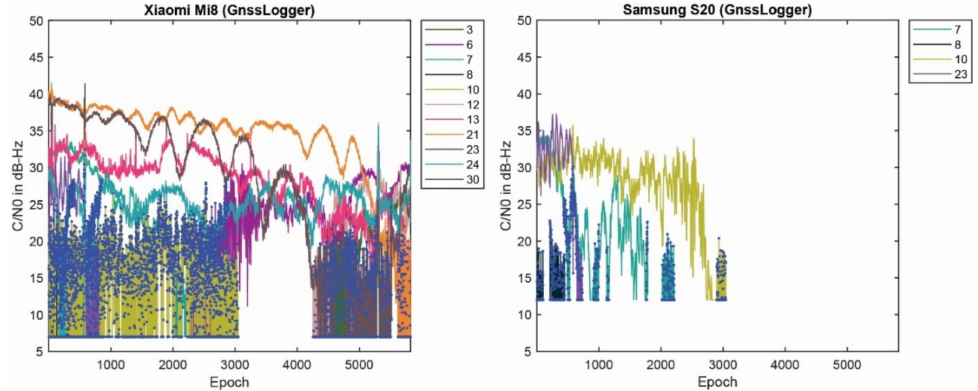
Figure 10. C/N0 records of GPS PRNs with problem in carrier-phase observations logs for Xiaomi Mi8 and Samsung S20 (Blue dots: epochs of carrier-phase observations with no change over time).